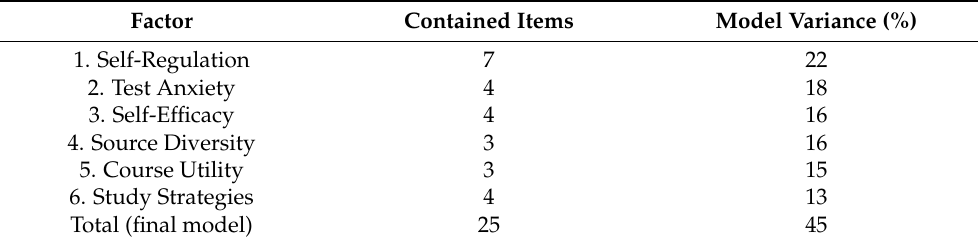
Table 6. Final model item loadings and variance